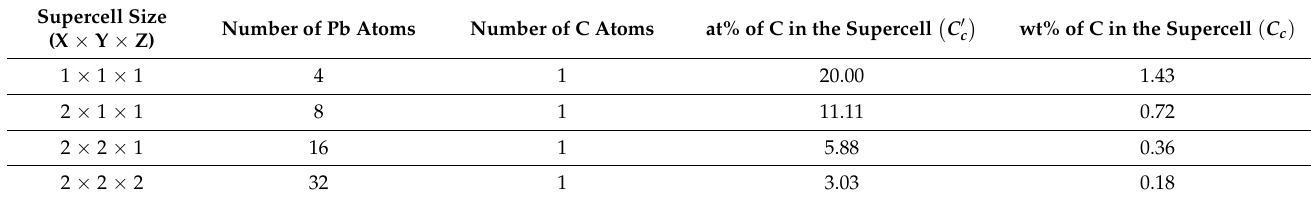
Table 1. Estimation of at% and wt% of C in different Pb supercell sizes